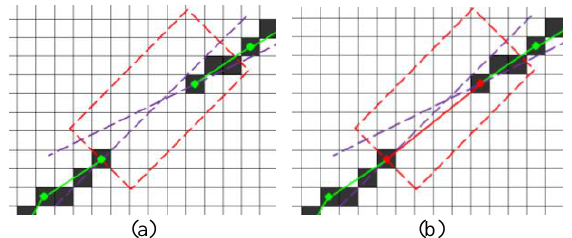
Figure 7. Edge merging process: the red box defines the bounding box for the merging process; violet lines defines the edge direction in correspondence of the extremes (red points).